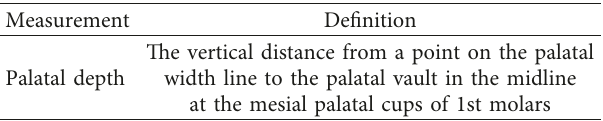
Figure 4: Illustration of the maxillary and mandibular arches’ lengths as described by Al-Zubair [11]. Anterior palatal length: the vertical distance from the incisal point to the intercanine distance line; molar vertical distance (palatal length): the vertical distance from the incisal point perpendicular to a line between the mesial lingual cusp tips of the first molars; total palatal length: the vertical distance from the incisal point to the midpoint of a line between the distal buccal cusp tips of the second molars; anterior mandibular length: the vertical distance from the incisal point to the intercanine distance line; molar vertical distance (mandibular length): the ver- tical distance from the incisal point perpendicular to a line between the mesial lingual cusp tips of the first molar; total mandibular length: the vertical distance from the incisal point to the midpoint of a line between the distal buccal cusp tips of the second molar. Table 1: Definitions of palatal depth as described by Al-Zubair